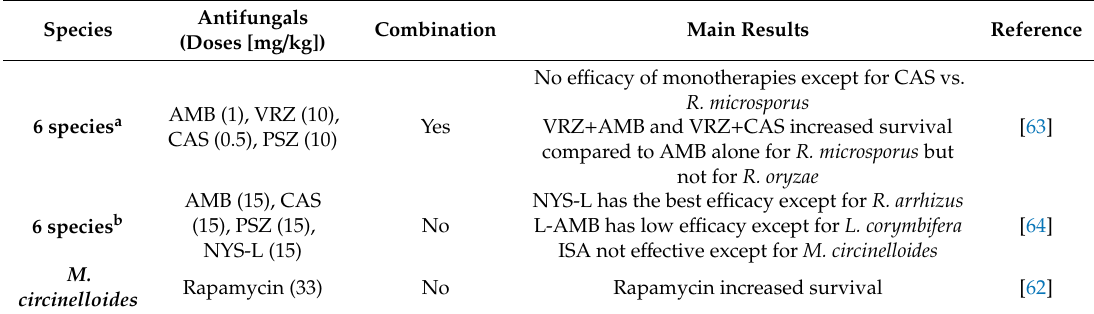
Table 5. Evaluation of antifungal treatment against Mucorales in Galleria mellonella